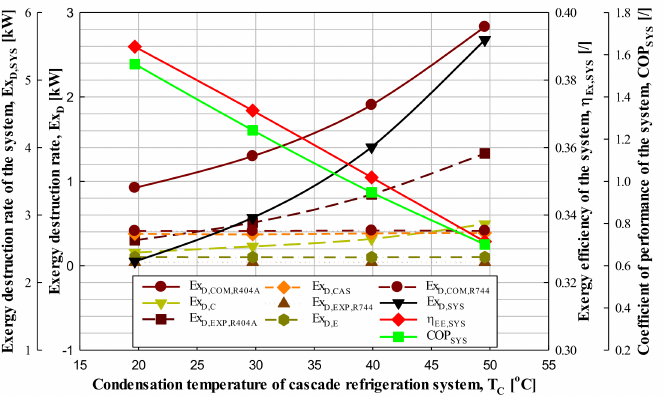
Figure 7. Exergy destruction rate, exergy efficiency and COP of the CRS with respect to condensation temperature of the